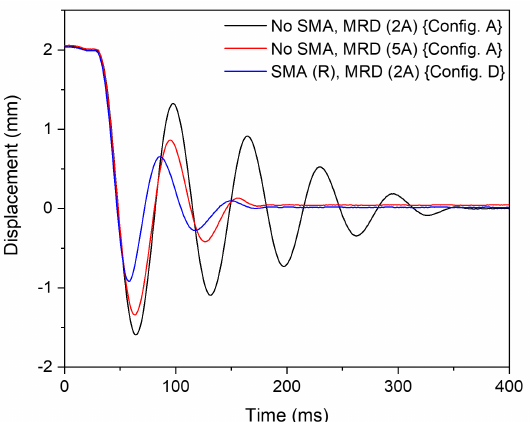
Figure 17. The displacement behaviour versus time demonstrating the effect of hybrid SMA–MR damper (‘Config. D’) and MR damper (‘Config. A’) for a loading of 2 mm.